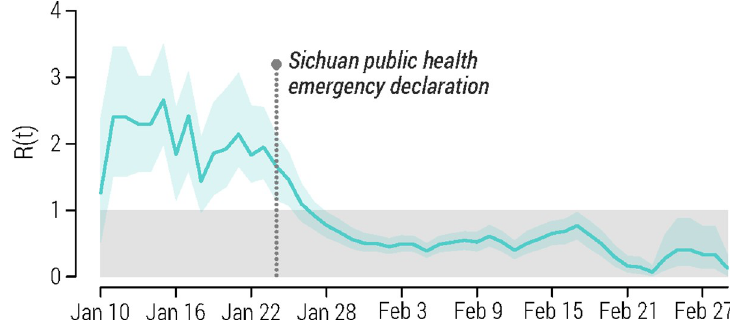
Fig 2. Estimated daily reproduction R(t) (mean and 95% CI) over a 5-day moving